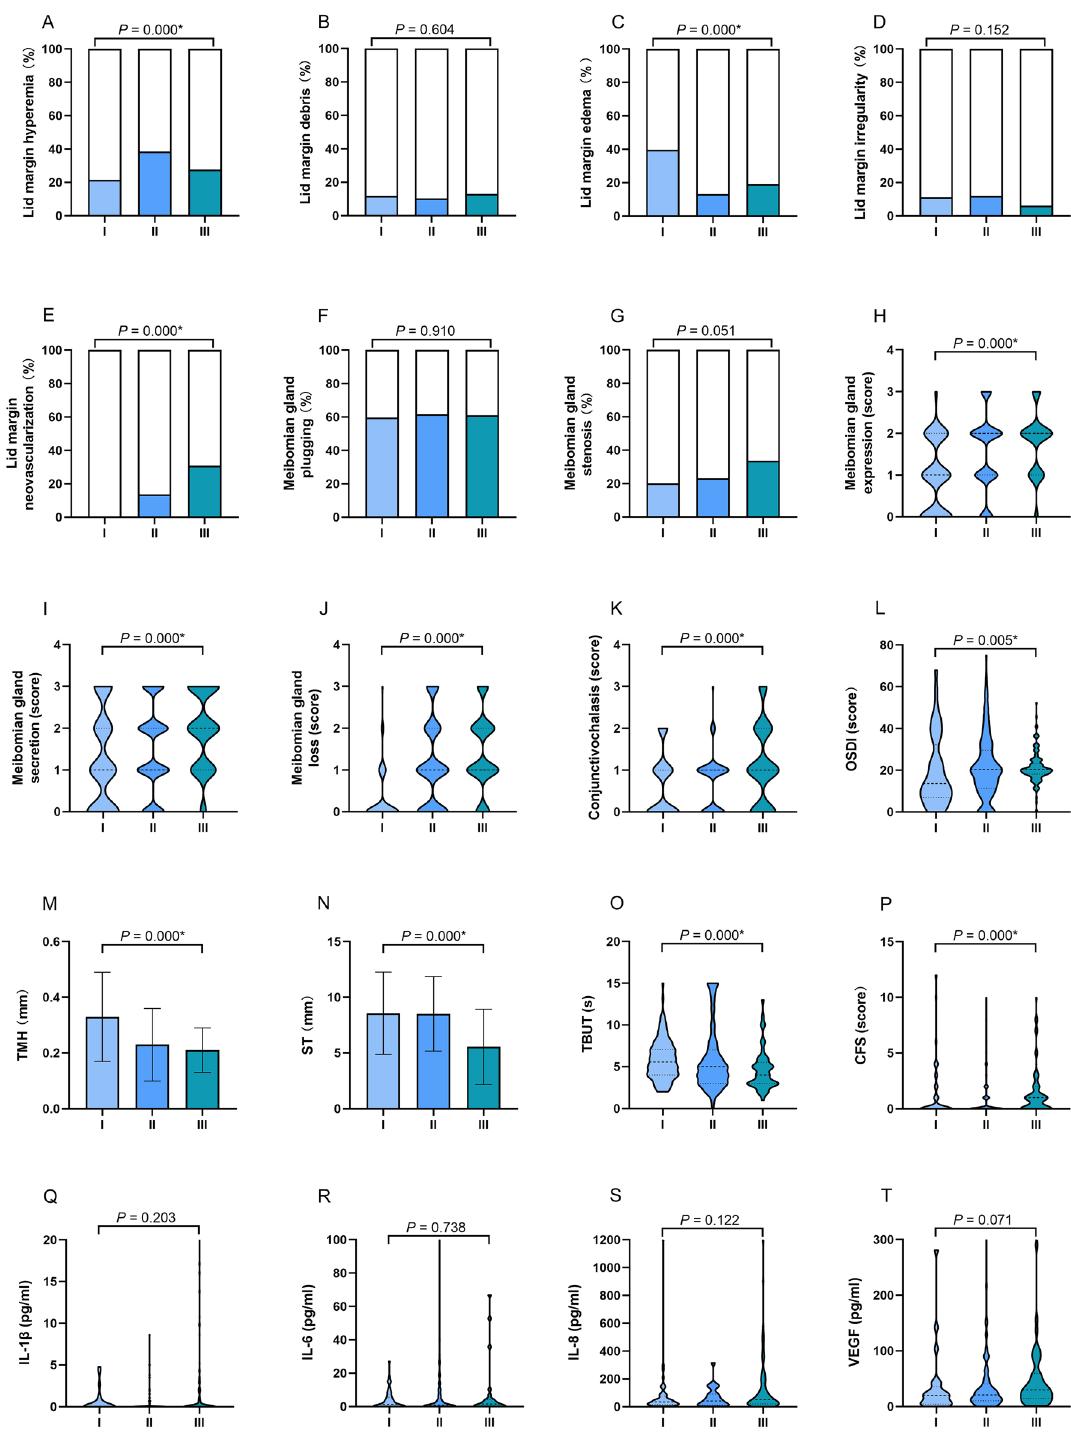
Figure 2. The ocular surface status and cytokine levels of the AQI level groups during long-term exposure. Individuals in Level II group exhibited a high proportion of lid hyperemia ( A ), Level I group exhibited a high proportion of eyelid edema ( C ), Level III group demonstrated a relatively high proportion of eyelid neovascularization ( E ), higher levels MG expression ( H ), MG secretion ( I ), MG loss ( J ), and conjunctivochalasis ( K ) than those in other groups. Individuals in Level III group had a significantly higher OSDI ( L ), lower TMH ( M ) and ST ( N ), shorter TBUT ( O ), and higher CFS score ( P ). The concentrations of IL-1β, IL-6, IL-8, and VEGF in three groups showed no difference. The results were expressed as percentage in A-G; as median with interquartile range in ( H – L ) and ( O – T ); as mean ± standard deviation (SD) in ( M , N ). AQI levels I: 0–50, II: 51–100, III: 101–150; OSDI ocular surface disease index, TMH tear meniscus height, ST Schirmer’s I test, TBUT tear film break-up time, CFS corneal fluorescein staining, IL-1β interleukin 1 beta, IL-6 interleukin 6, IL-8 interleukin 8, VEGF vascular endothelial growth factor, * P <